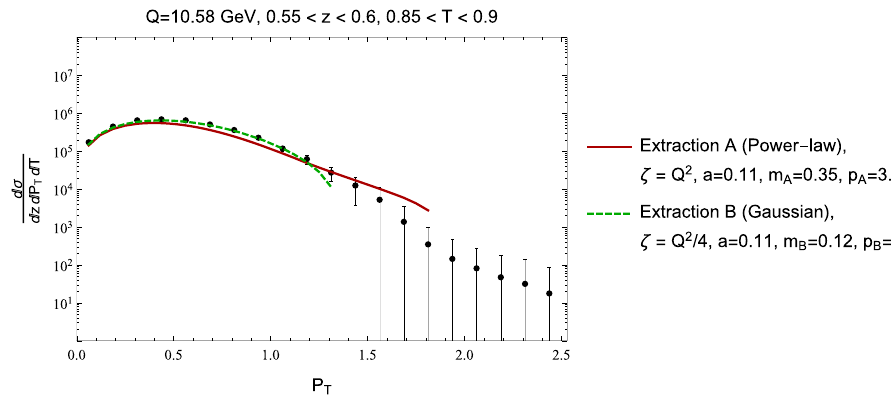
Fig. 8 e + e − → H X LO cross section computed according to Eq. (115) using two different parameterizations for its non-perturbative part, and at two different values of the rapidity cut-off ( ζ = Q 2 solid black line, 0 ζ = Q 2 / 4 dashed green line). 0 See text for more